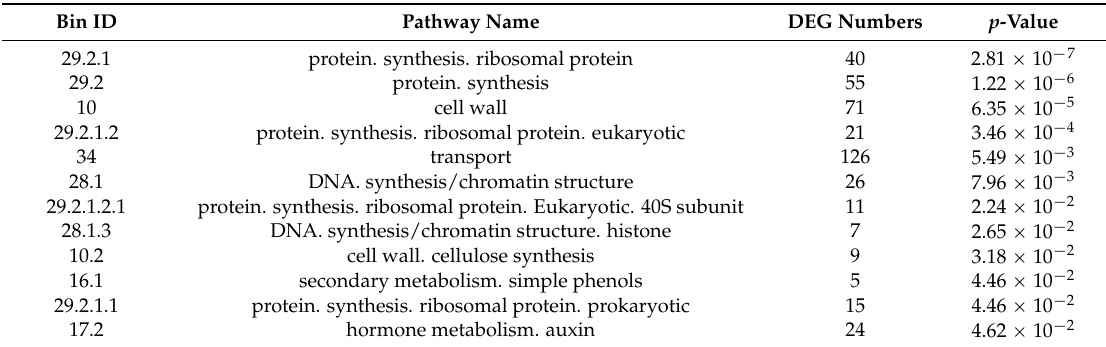
Table 2. HLB-modulated pathways in ponkan leaves, showing the 12 pathways significantly changed following HLB infection at 26 wpi ( p -value ≤ 0.05).